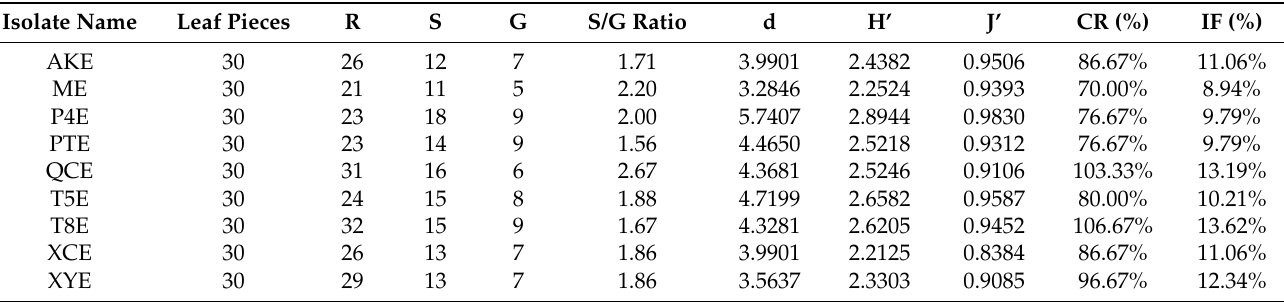
Table 4. Records and diversity of fungal endophytes associated with coffee hosts from different population sites. R = individuals/records, S = number of species, G = number of genera, d = Margalef diversity, H’ = Shannon diversity index, J’ = Pielou evenness index, CR = colonization rate, IF = isolation